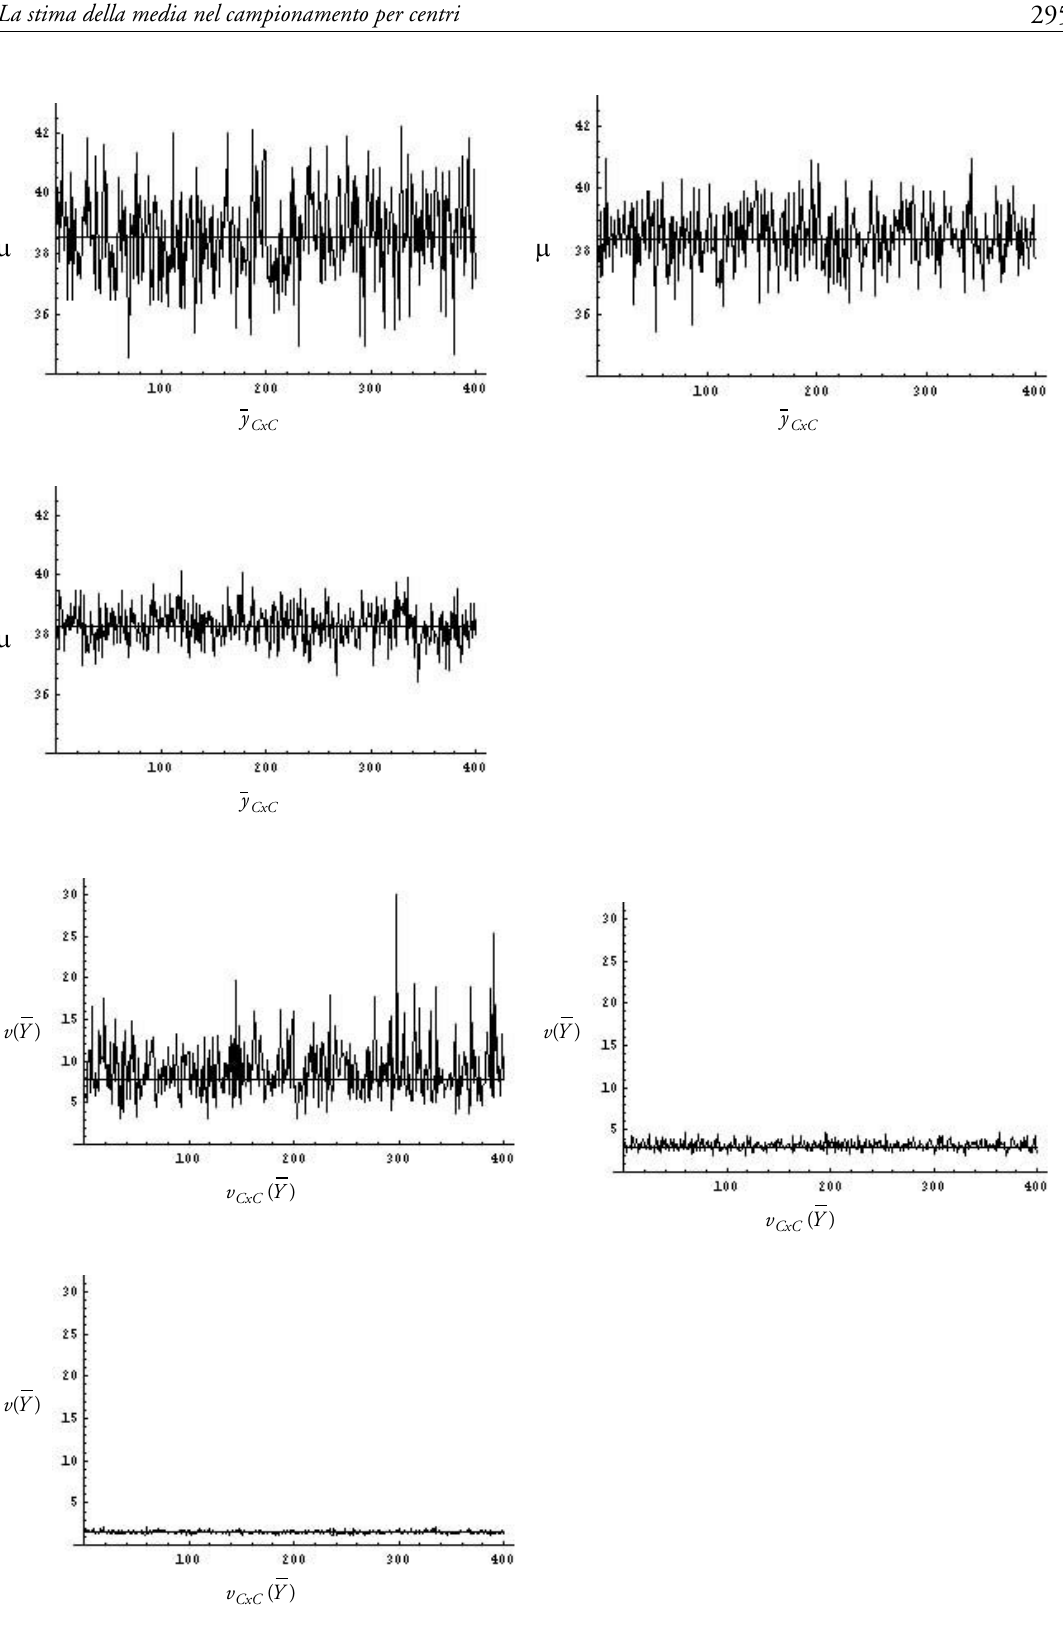
Figura 1 – Distribuzioni Monte Carlo degli stimatori y